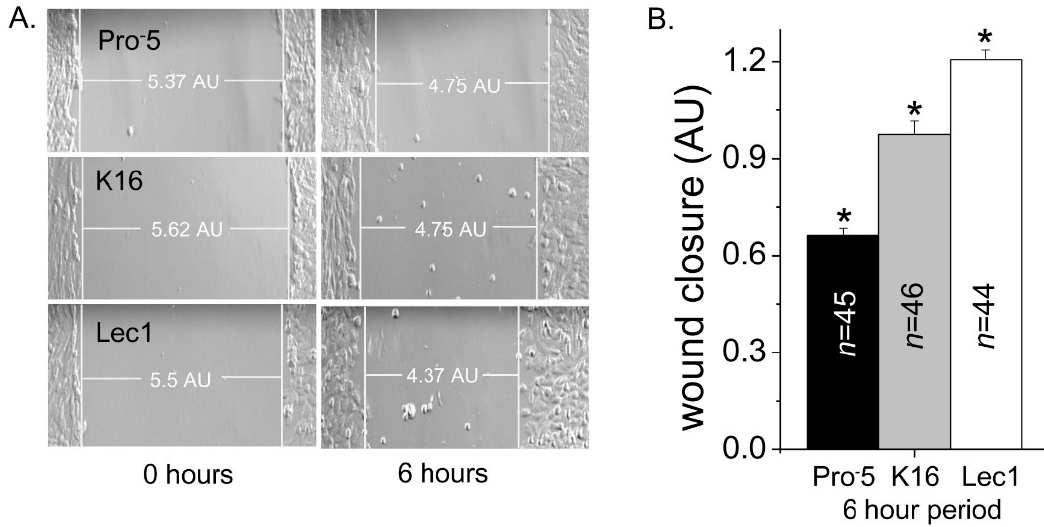
Figure 4. Rate of CHO cell migration is altered by type of N -glycan. Images were captured at 0 and 6 h time points for parental and N -glycosylated mutant CHO cell lines, as indicated ( A ); rate of cell wound closure was determined for the various CHO cell lines ( B ). White lines at the leading edge of the cell monolayers, and the horizontal line connecting these two vertical lines represent the width of the cell wound. n denotes the number of cell wounds measured from four separate experimental days. Asterisks indicate significant differences in mean values at a probability of p < 0.03 using one-way ANOVA with Bonferroni adjustments.